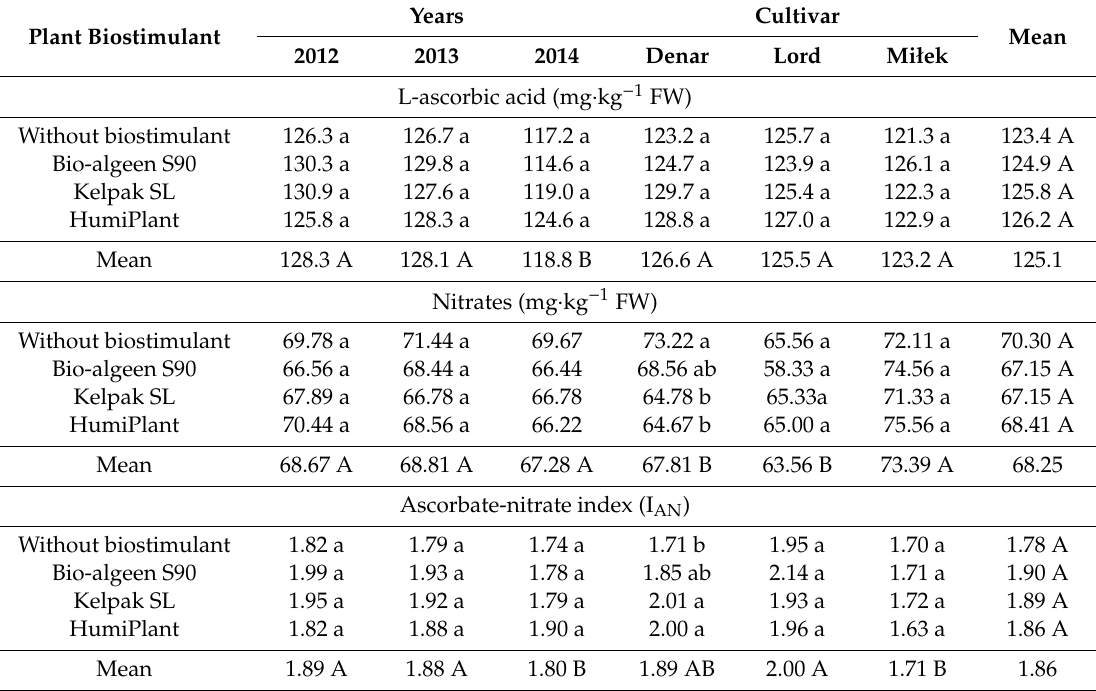
Table 7. L-ascorbic acid and nitrates content in potato tubers. Plant